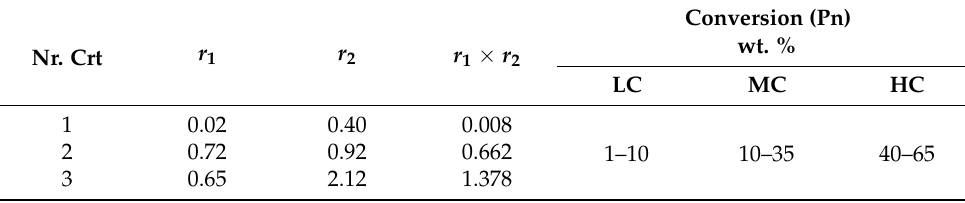
Table 2. The conditions of the analysis plan for methods